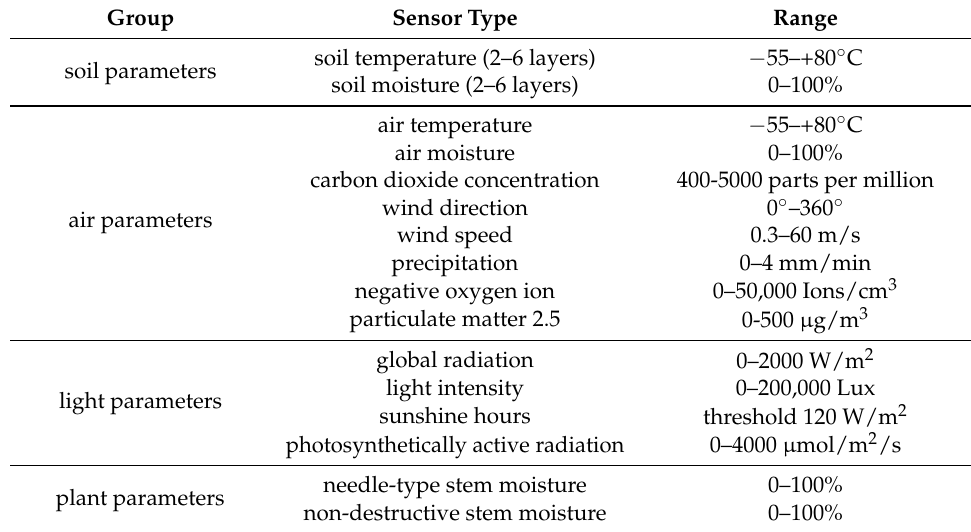
Table 1. Sensor configuration and performance of the forest microclimate monitoring